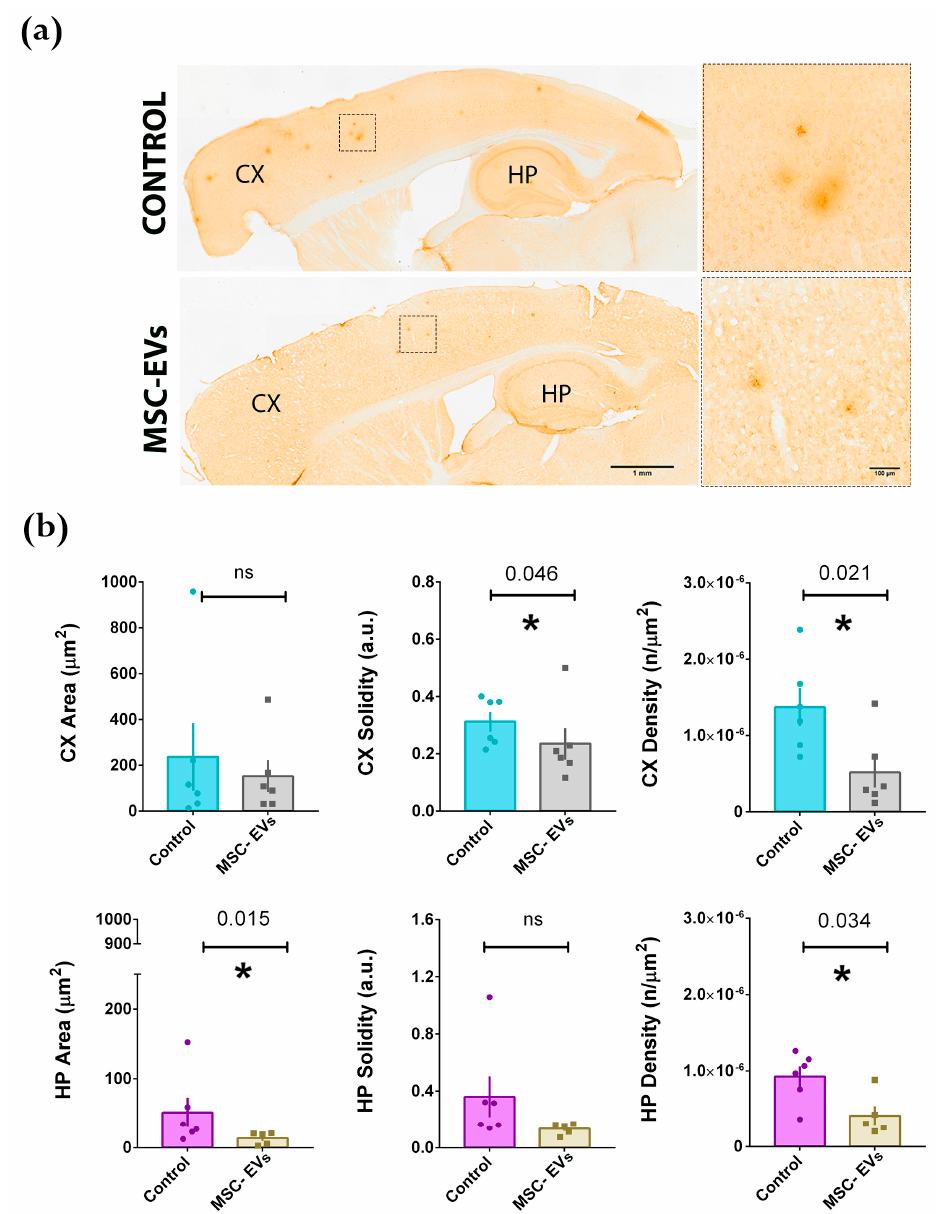
Figure 4. Intracerebral injection of BM-MSC-EVs (MSC-EVs) into 3-month-old APP / PS1 mice reduces amyloid deposition after ~1 month. ( a ) Immunohistochemical staining (DAB) of A β 1-42 plaques in brains of APP / PS1 mice treated with vehicle (CONTROL, top) or MSC-EVs (bottom). Scale bar: 1 mm. Panels on the right show higher magnification of representative plaques, contoured in the inset. Scale bar: 100 µ m. Cortex (CX) and Hippocampus (HP) are indicated. ( b ) Quantification of A β 1-42 positive plaques in the Cortex (CX; upper graphs: light blue and grey histograms) and in the hippocampus (HP; lower graphs: violet and brown histograms). Each dot represents an animal for which 10 slices have been scored. Statistical analysis was performed by non-parametric Mann-Whitney test (* p < 0.05; ** p < 0.01).